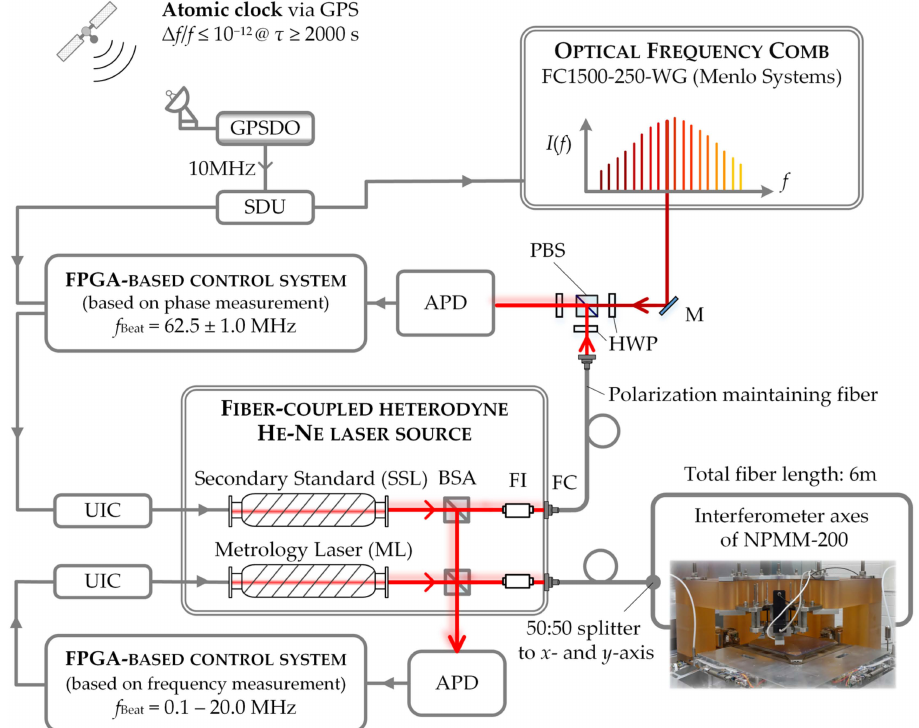
Figure 6. Layout of the comb-referenced He-Ne heterodyne source. The abbreviations denote: GPSDO—GPS disciplined oscillator, SDU—signal distribution unit, APD—avalanche photodiode, PBS—polarizing beam splitter, M—mirror, BSA—beam splitter assembly, FI—Faraday isolator, FC—fiber coupling, UIC—transconductive amplifier (U/I converter), FPGA—field programmable gate